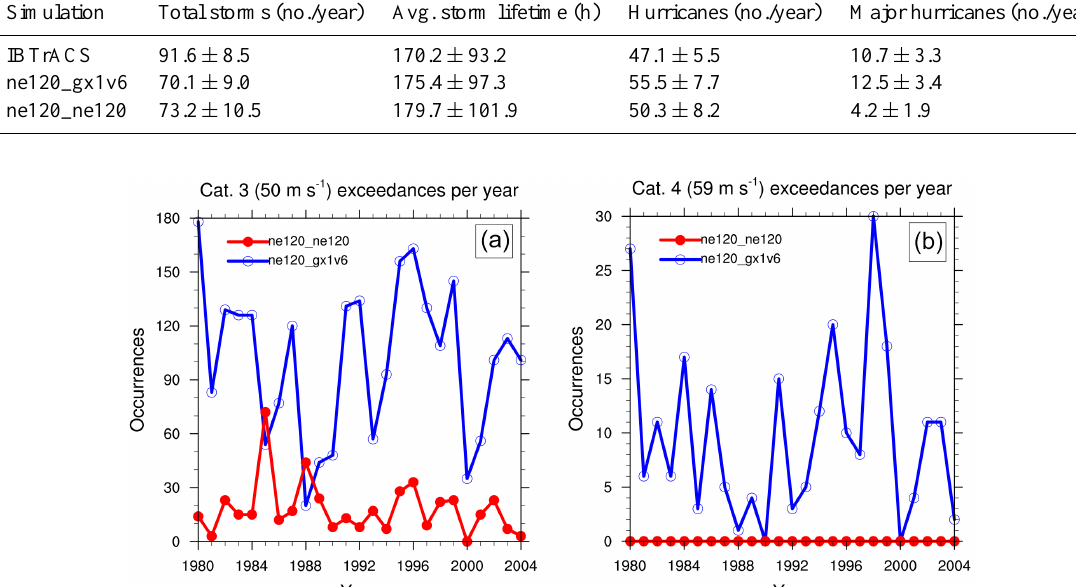
Figure 4. Number of TC surface wind instances exceeding category 3 and category 4 wind thresholds for AMIP simulation coupled to 1 ◦ ocean grid (ne120_gx1v6) and 0.25 ◦ ocean grid (ne120_ne120). Instances are calculated using 3-hourly TC